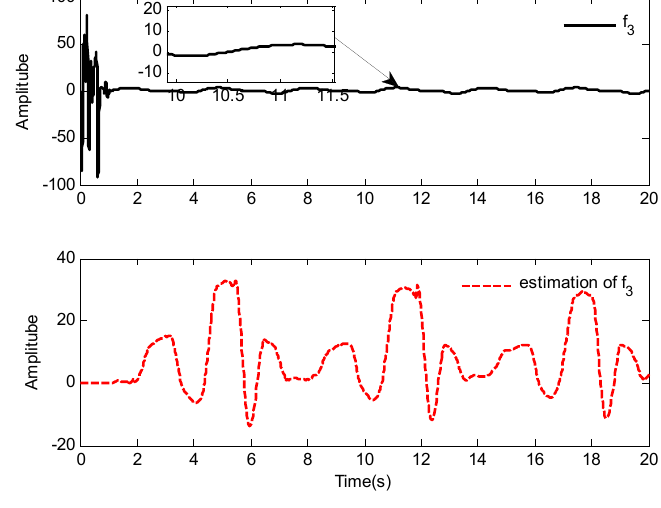
Figure 6. Response of f 3 and ˆ f 3 .